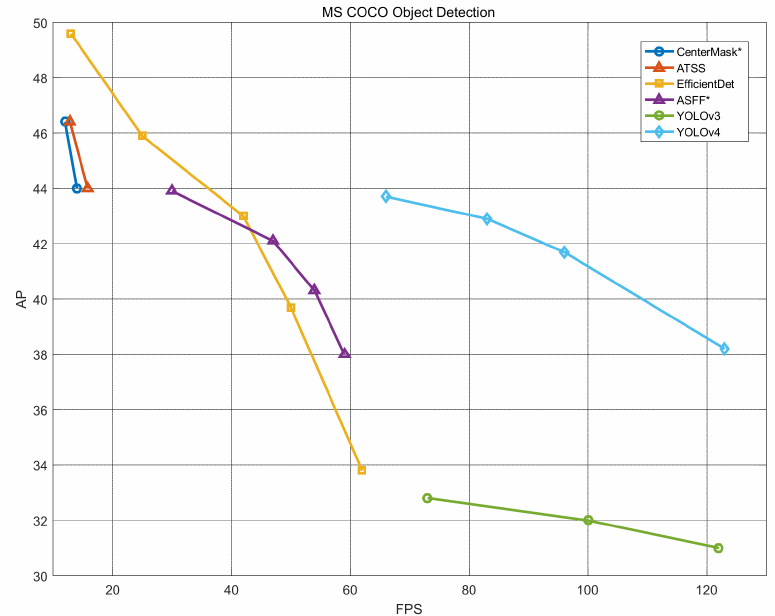
Figure 1. Comparison between YOLOv4 and other state-of-the-art object detectors. (* AP refers to average accuracy. FPS refers to the number of frames processed per second. YOLOv4 is more faster than EfficientDet with the same AP value and improves YOLOv3’s AP and FPS by 10% and 12%,